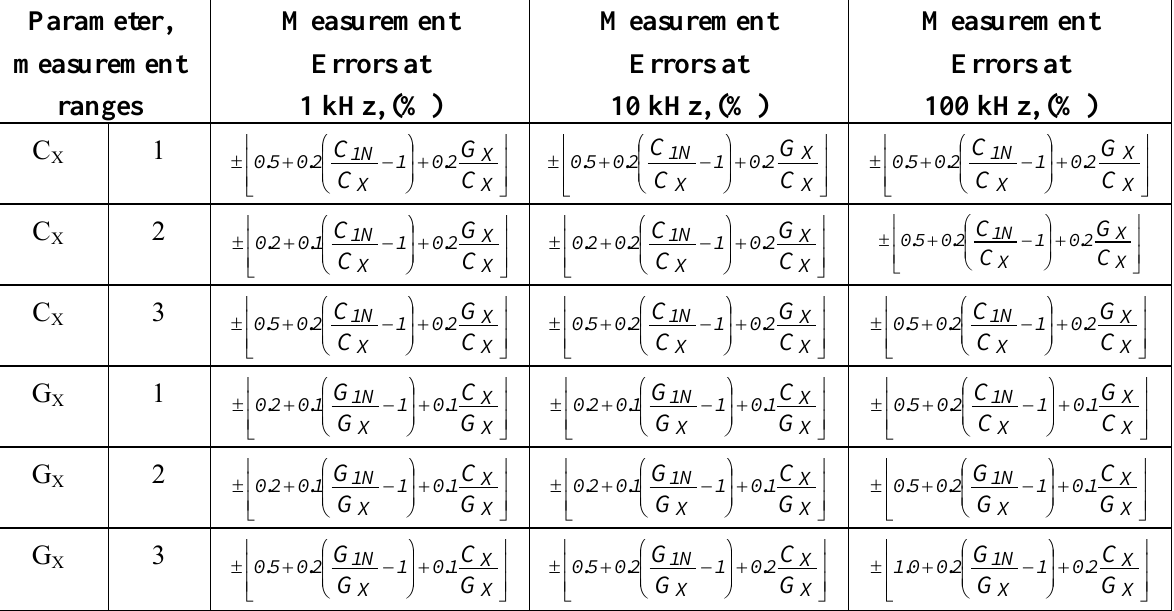
Table 4. Parameters, measurement intervals, and errors of C-V , G-V characteristic measurement